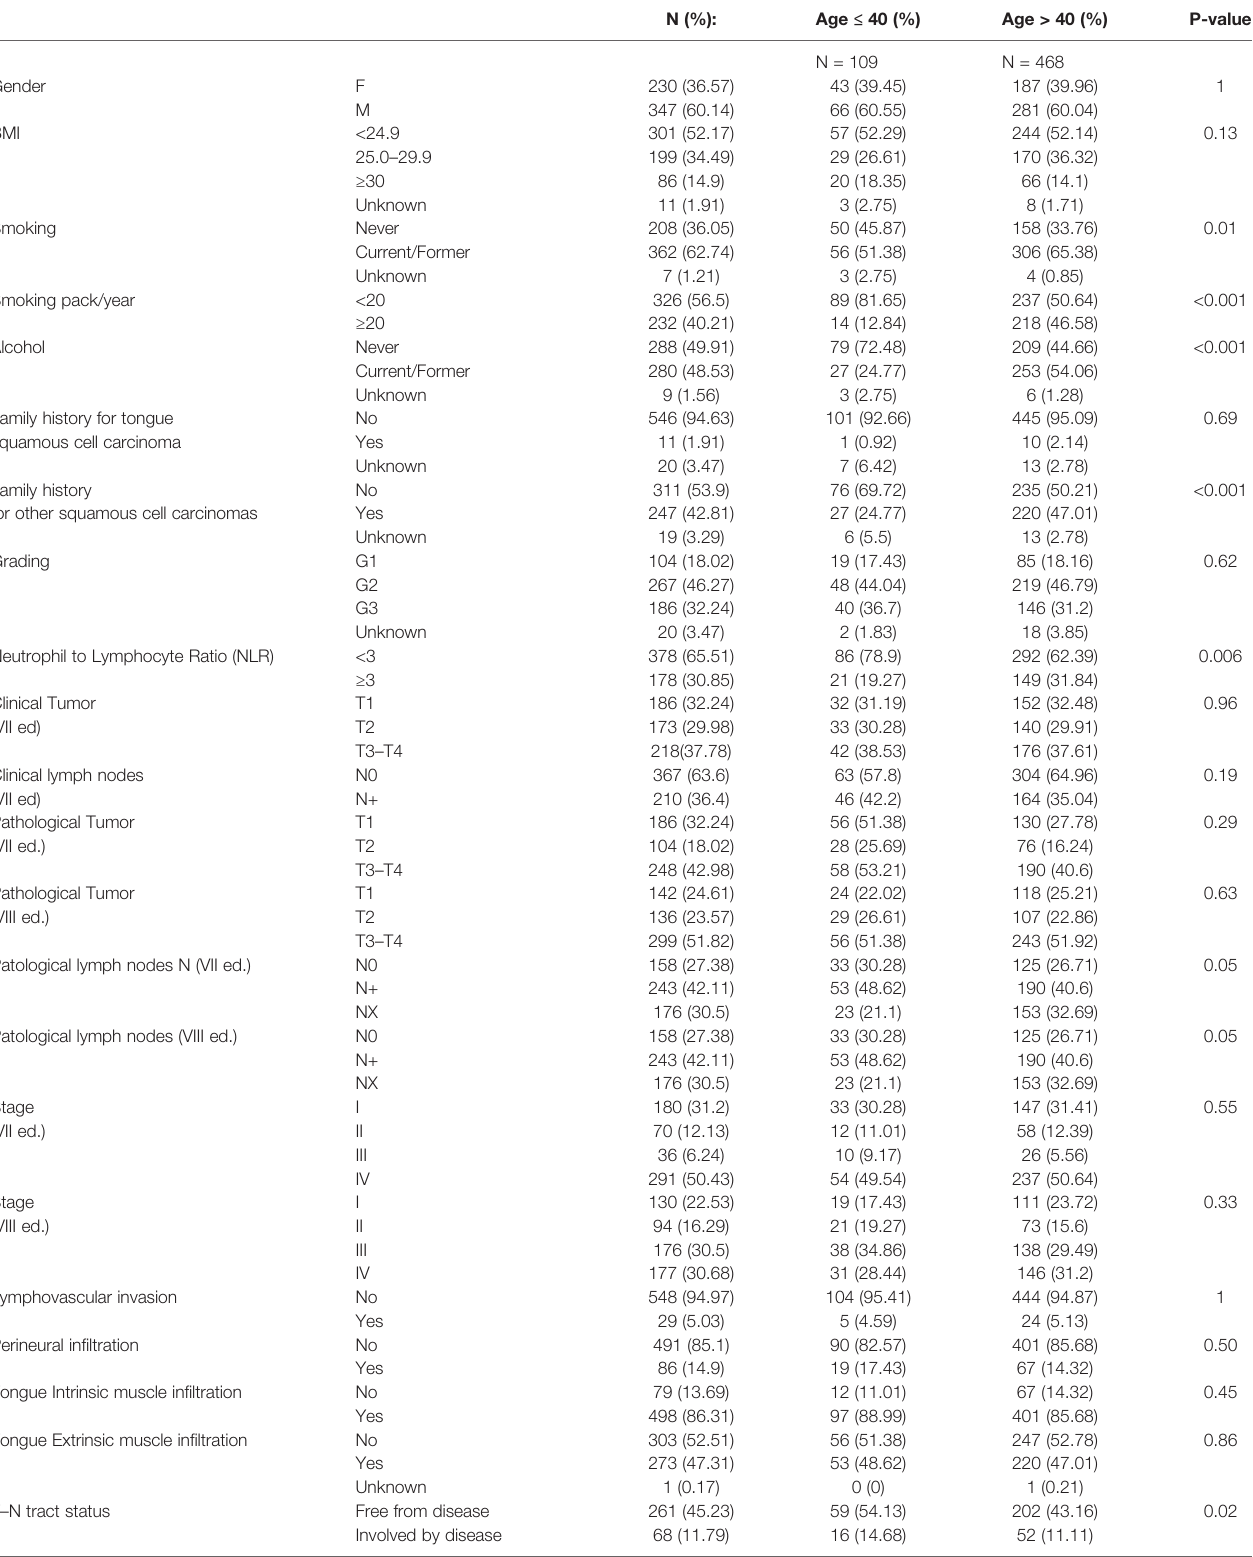
TABLE 1 | Patients ’ , tumor and treatments characteristics according to